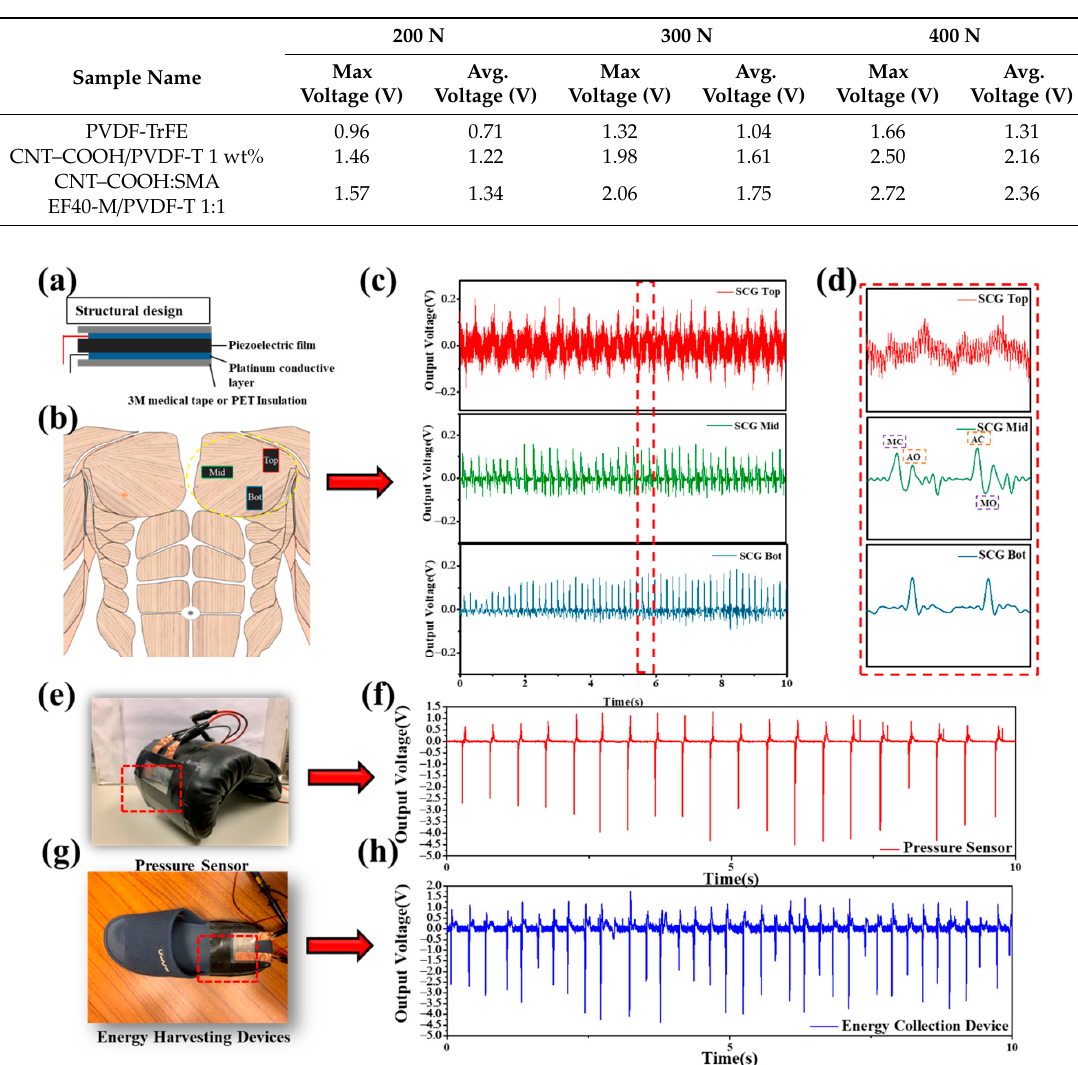
Table 3. Continuous output voltage results of PVDF-TrFE, CNT–COOH / PVDF-T 1 wt%, and CNT–COOH:SMA EF40-M / PVDF-T 1:1.